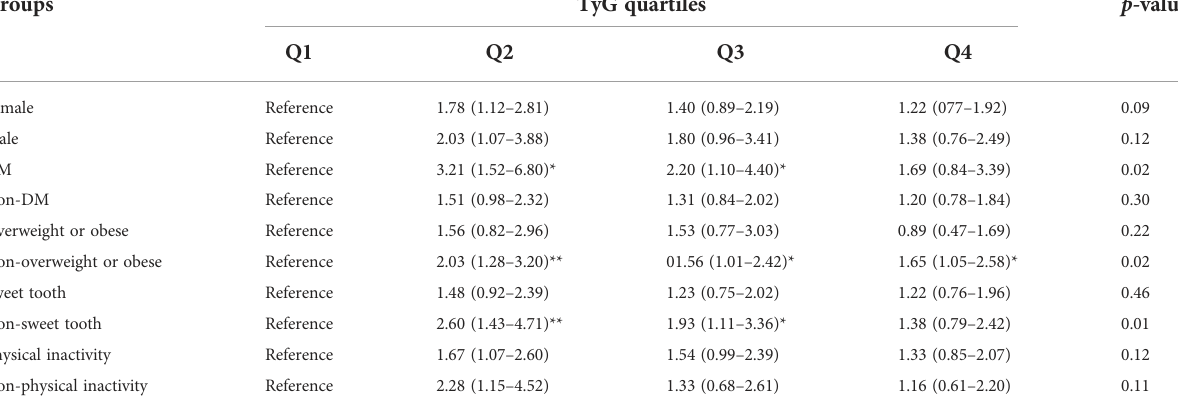
TABLE 4 Odds ratios (95% con fi dence intervals) of the subgroup analysis for triglyceride – glucose (TyG) and carotid plaque in the high-stroke- risk population.